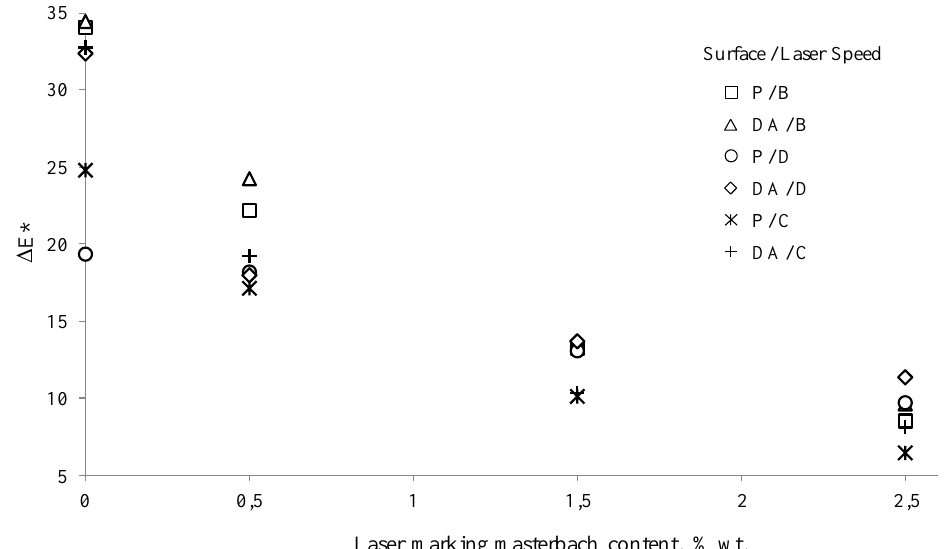
Figure 6. Influence of the laser marking masterbatch content on the value of the Δ E * for the P and DA surfaces, obtained with the laser marking velocity of B (750 mm·s −1 ), C (1050 mm·s −1 ), and D (1350 mm·s −1 ).